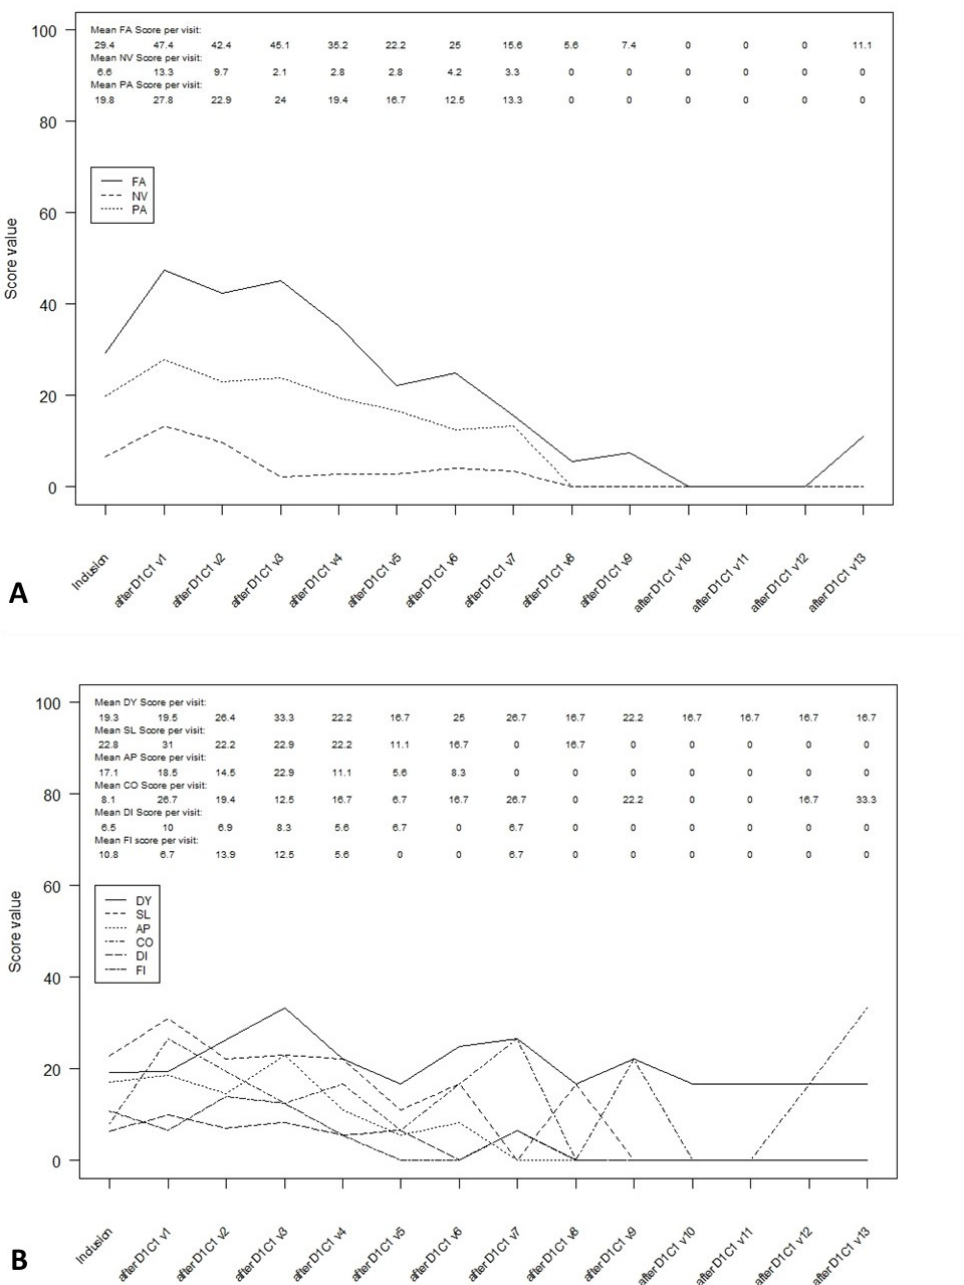
Figure 3. Symptom scales in ITT overall population during follow-up. ( A ): Multi-item symp- tom scales in ITT overall population. ( B ): Single-item symptom scales in ITT overall population. FA: fatigue; NV: Nausea and vomiting; PA: pain; DY: dyspnea; SL: insomnia; AP: appetite loss; CO: constipation; DI: diarrhea; FI: financial